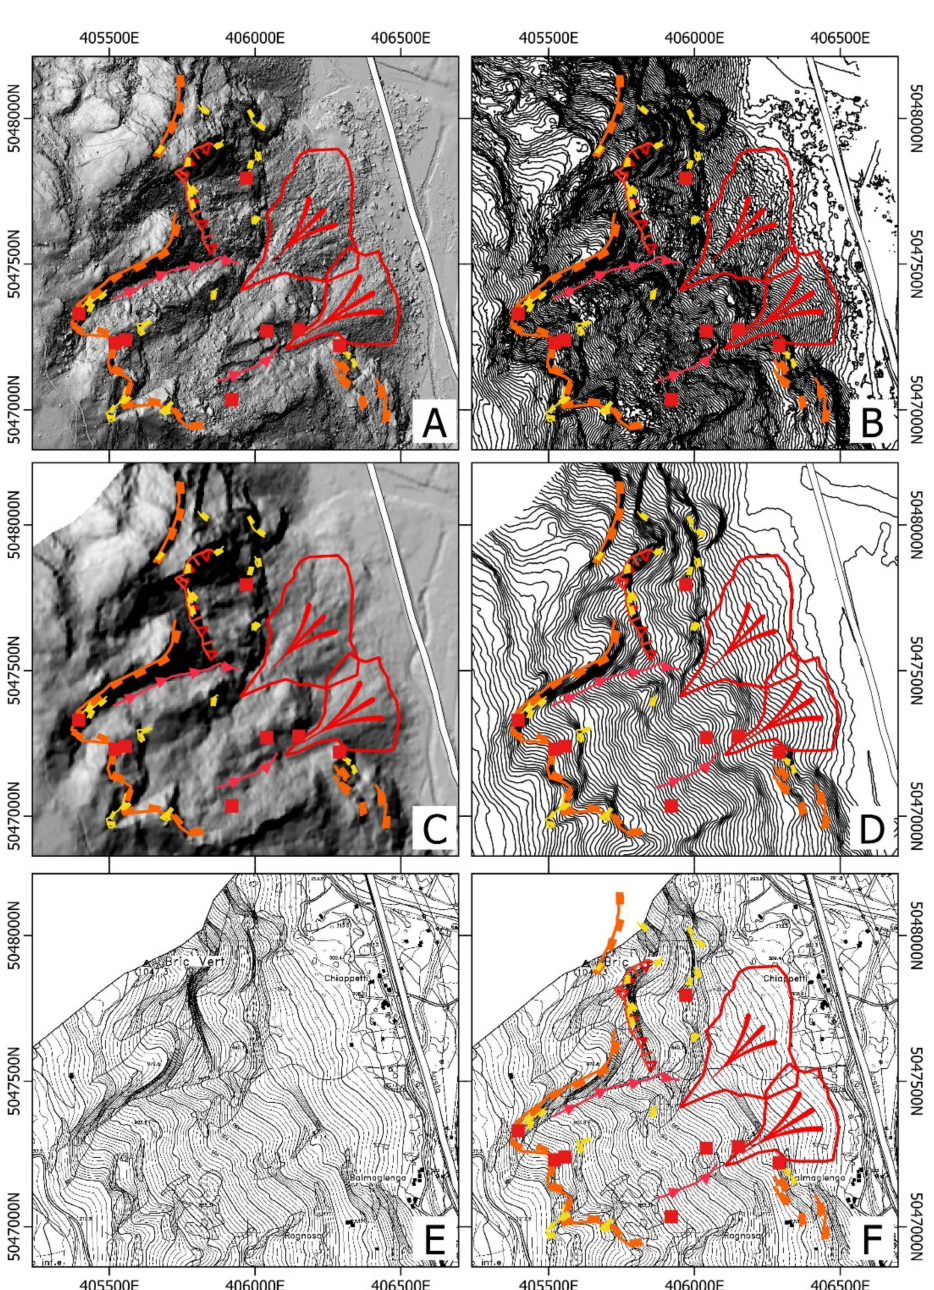
Figure 15. Graphic comparison between GOGIRA’s geomorphological map and available topograph- ical data. ( A ) Hillshade from 0.5 m DTM. ( B ) 10 m contour from 0.5 m DTM. ( C ) hillshade from 5 m DTM. ( D ) 10 m contour from 5 m DTM. ( E ) CTR map 1:10 k scale only. ( F ) CTR map 1:10k scale with GOGIRA’s geomorphological